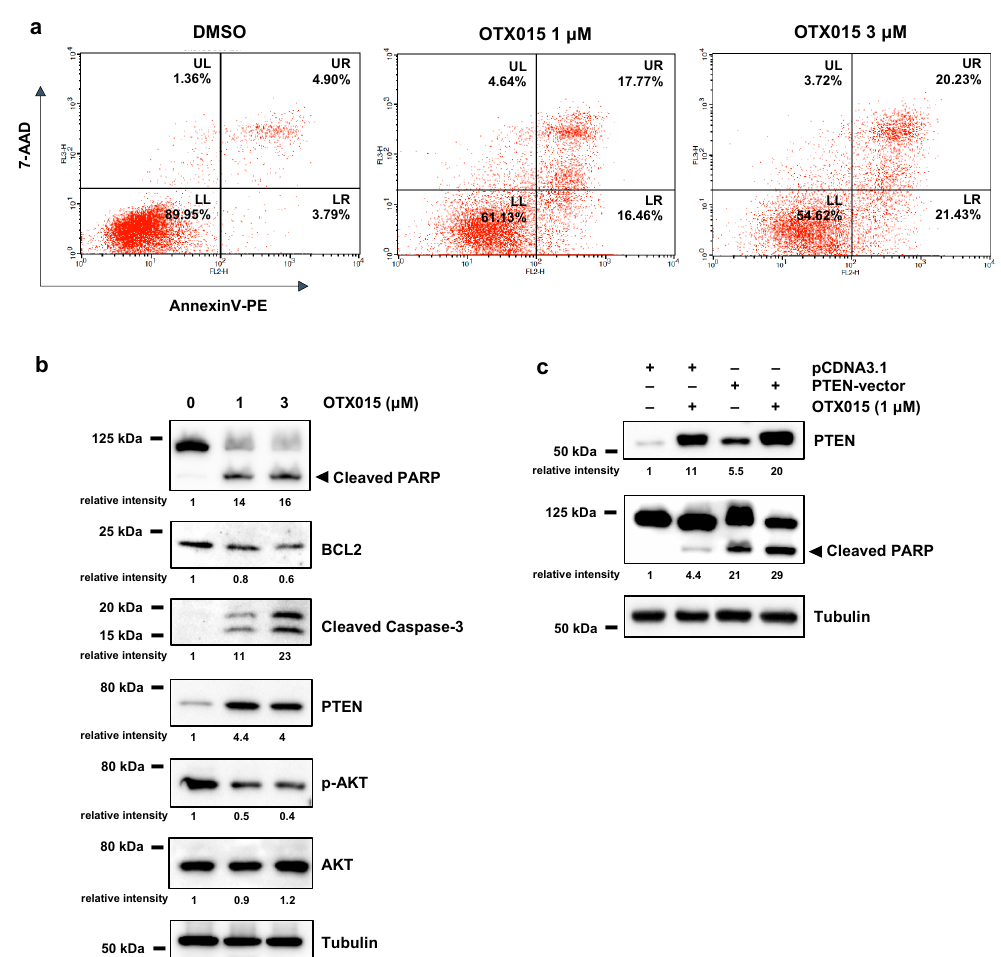
Figure 2. BET inhibition induces apoptosis by modulating PTEN/AKT. ( a ) Flow-cytometry assays by Annexin V/7AAD staining show cell death rates in OTX015-exposed SKOV3 cells (1 µ M and 3 µ M) and DMSO controls. Representative dot plots with mean values of two independent experiments showing the percentage of viable cells (quadrant LL, Annexin V − /7AAD − ), early apoptotic cells (quadrant LR, Annexin V+/7AAD − ), late apoptotic cells (quadrant UR, Annexin V+/7AAD+) and necrotic cells (quadrant UL, Annexin V − /7AAD+). ( b ) WB analysis of the apoptotic markers cleaved PARP, BCL2 and Caspase-3 in OTX015-exposed SKOV3 cells (0–1–3 µ M) for 72 h. Protein analysis showing the strong PTEN increase and the downregulation of phospho (p)-AKT levels in OTX015-exposed SKOV3 (0–1–3 µ M) for 72 h. Tubulin served as loading control and representative blot was shown. ( c ) WB experiments showing PTEN and cleaved PARP expression in SKOV3 cells transfected with PTEN-vector or pcDNA3.1 empty vector and treated with or without 1 µ M OTX015 for 72 h. Tubulin served as loading control and representative blot was shown. The original Western Blot images can be found in Figure